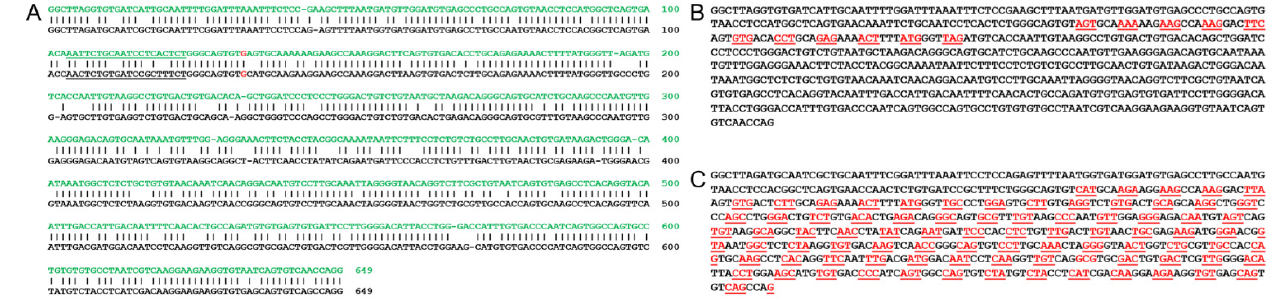
Figure 4. Comparison of human and mouse USH2A c.2299 exon sequences. ( A ) Human USH2A exon 13 DNA in green carrying c.2299G are aligned with mouse exon 12 DNA in black carrying c.2299G with gRNA underlined. The sequence alignment can help to develop the CRISPR/Cas9 gene editing strategies and predict outcomes of using mouse as in vivo models. ( B ) Human USH2A c.2299delG are listed to show the early termination of protein translation. ( C ) However, mouse Ush2a c.2299delG does not result in early termination of the protein translation. This sequence analysis can help to develop the CRISPR/Cas9 gene editing strategies and predict outcomes of using mouse as in vivo models.